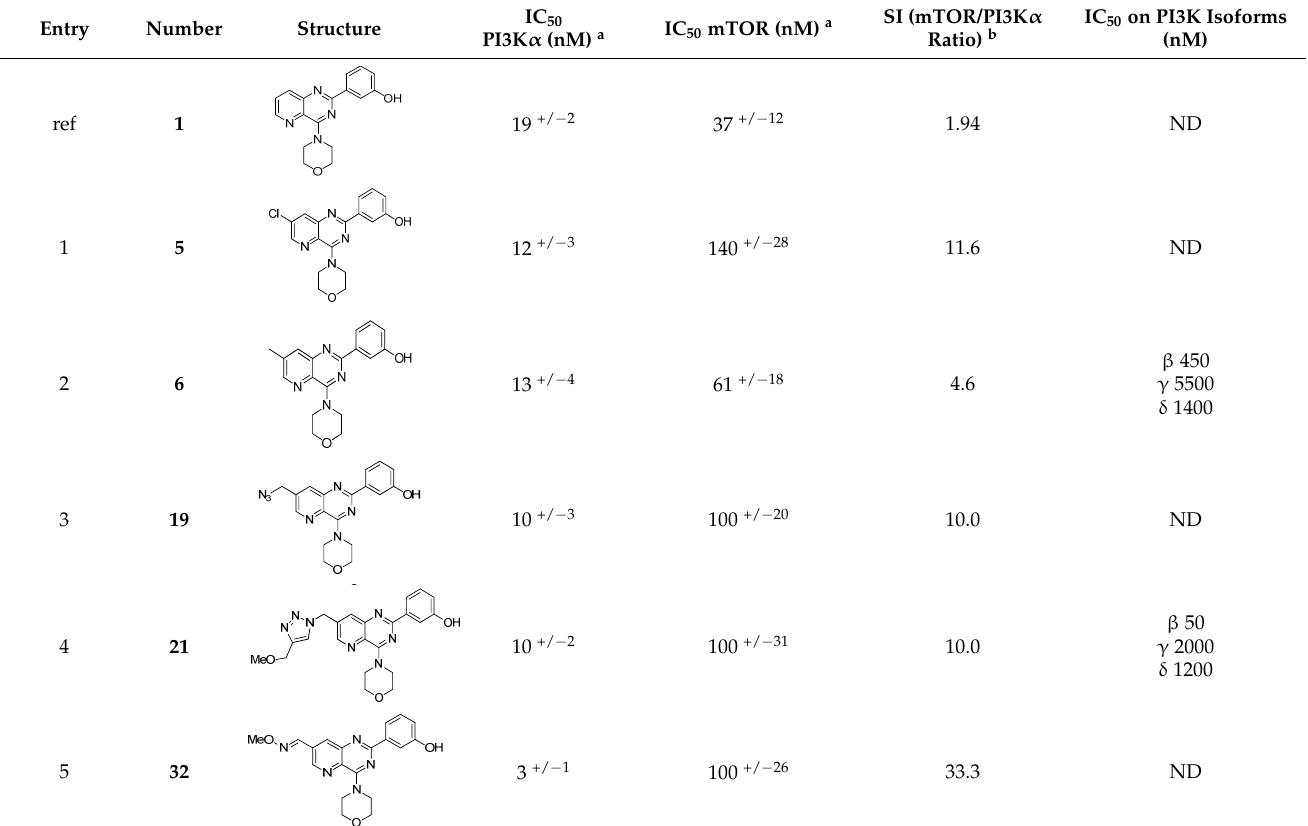
Table 2. Biological evaluation of dual PI3K/mTOR inhibition.